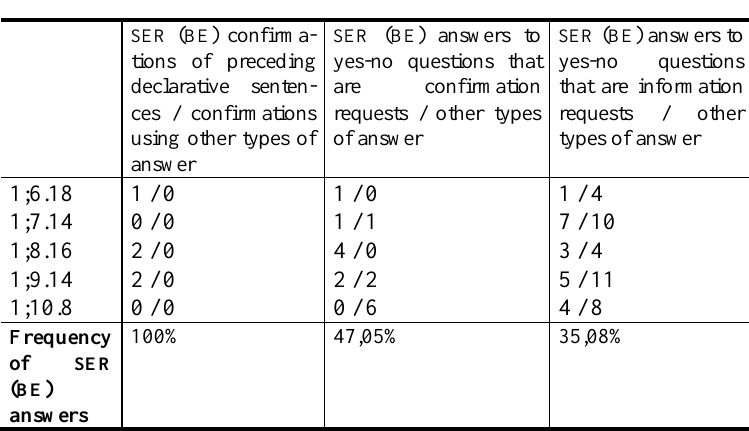
Table V. Occurrences of SER ( BE ) answers in confirmation and other contexts in Tomás’